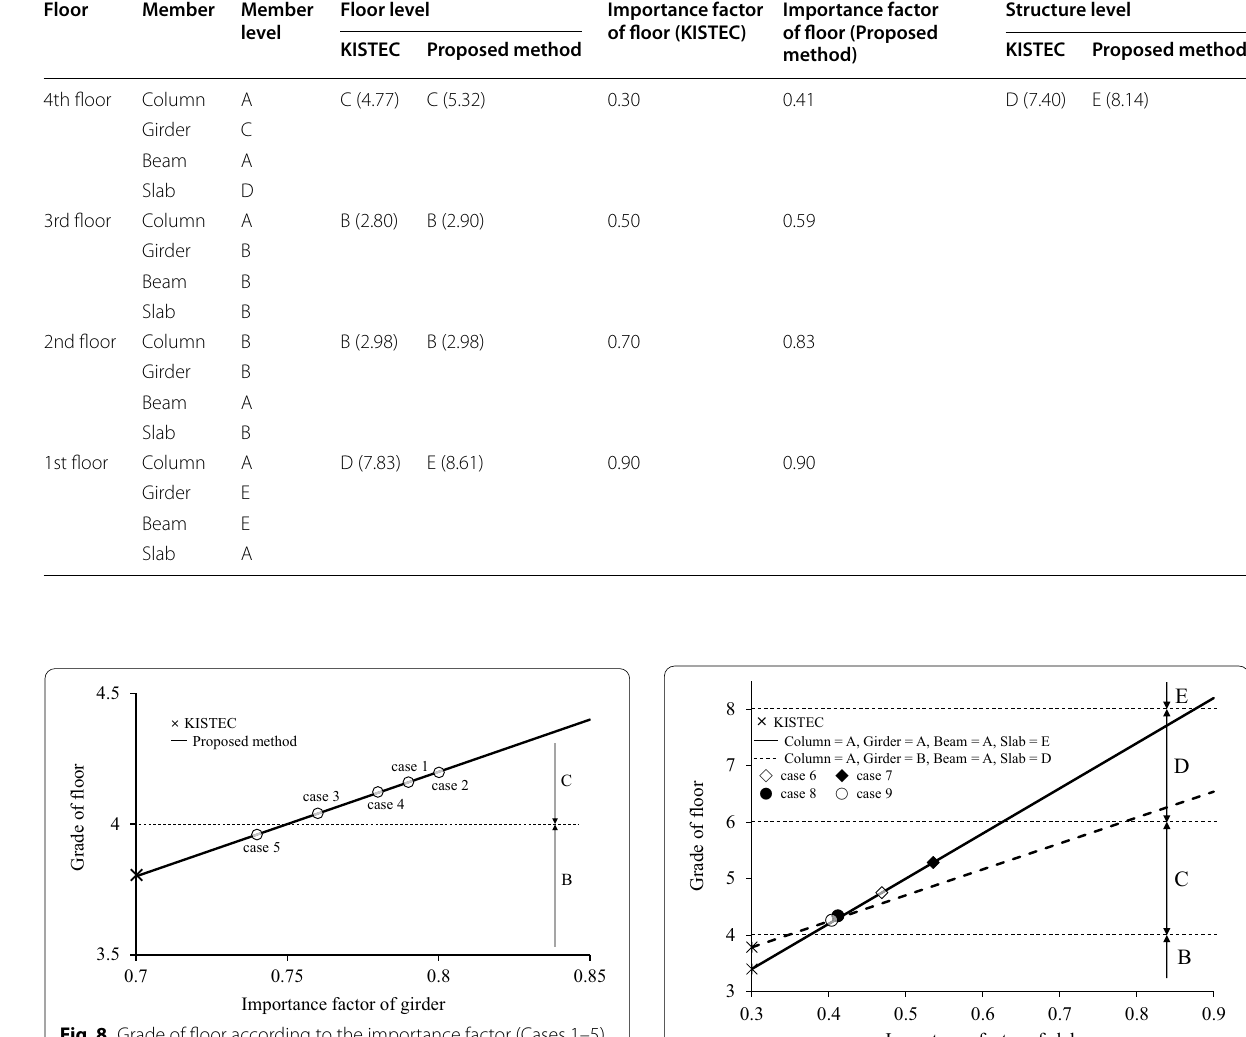
Table 9 Evaluation results for RC structures considering modified importance